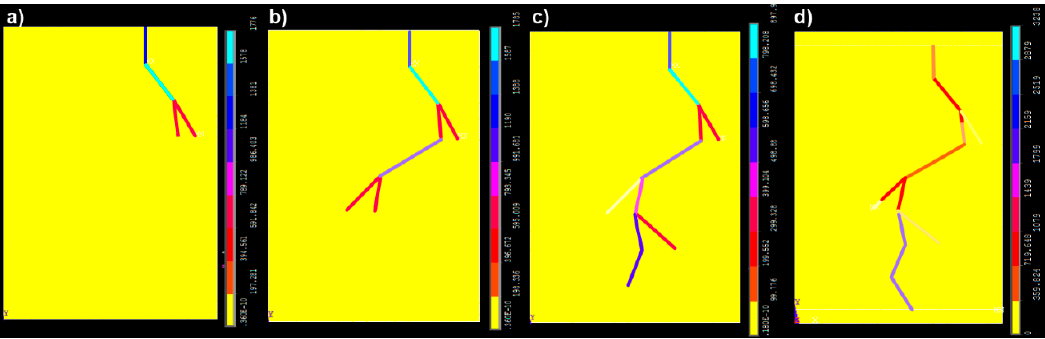
Figure 13. Densities of currents in streamers at various times ( a – d ) of the discharge development.